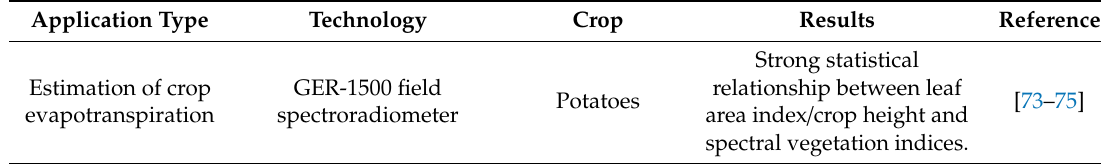
Table 3. Remote sensing applications in Cyprus